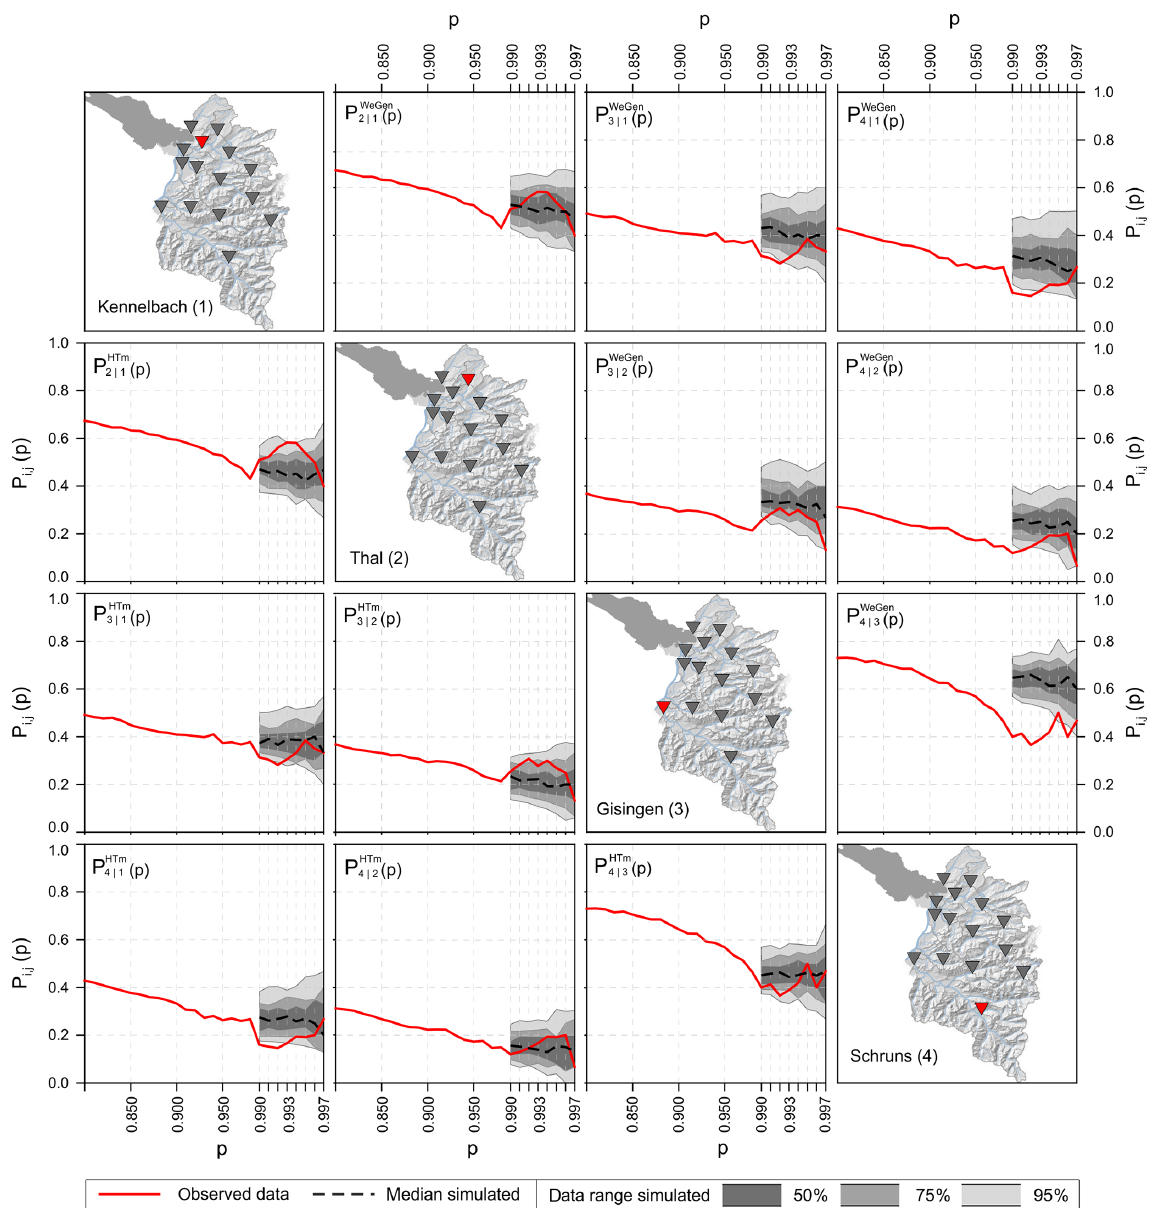
Figure 4. Comparison of observed (42 years) and simulated conditioned exceedance probability P i,j (p) . The range of the simulated results is based on 42 years of simulation with 100 realisations. The plots in the lower triangle correspond to the HT model, whereas those in the upper triangle show the WeGen